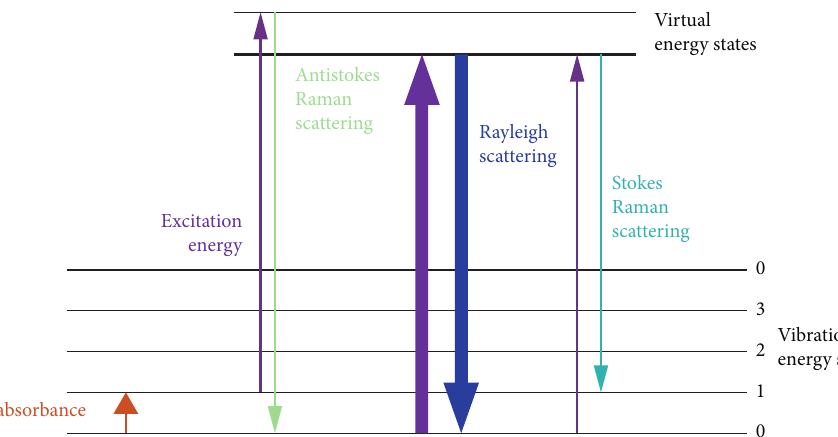
Figure 9: Diagram showing different types of scatterings